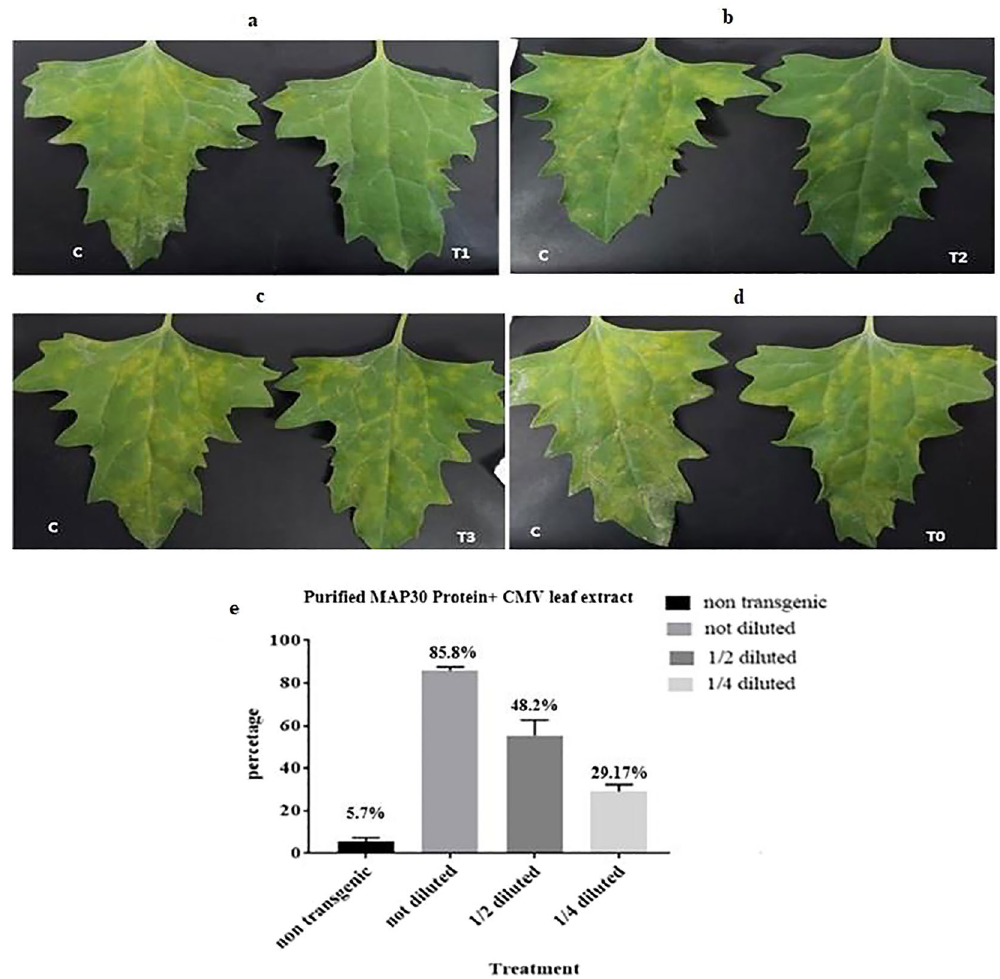
Figure 9. The simultaneous inoculation of C. quinoa seedlings Incubation the extraction-infected CMV and rMAP30 in three dilutions. Incubation with non-transgenic lines used as control (Table 4). There were 16 replicates for each assay. (a) The inoculation with undiluted rMAP30. (b) The inoculation with one second diluted rMAP30. (c) The inoculation with one quarter diluted rMAP30. (d) The inoculation with non- transgenic protein (T1, T2, T3, T0, and C respectively) indicate the treatment by undiluted, one second diluted, one quarter diluted rMAP30, non-transgenic protein, and CMV). (e) Viral infection intensity graph for rMAP30 in different dilutions versus non-transgenic protein. The results shows that the highest control percentage was observed when the rMAP30 was not